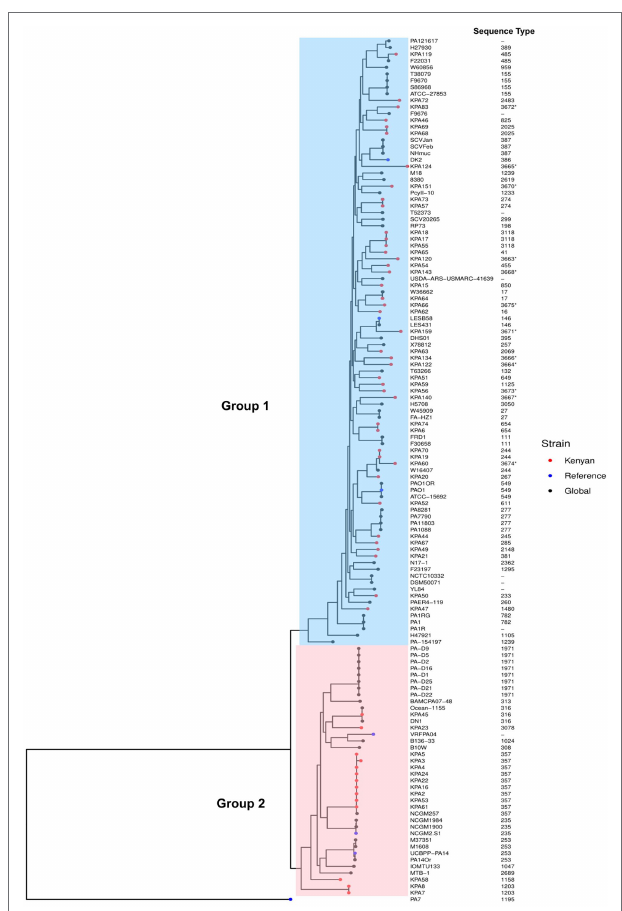
FIGURE 2 | Phylogenetic analysis of Kenyan and global strains of Pseudomonas aeruginosa . A maximum-likelihood phylogenetic tree of all study isolates and global strains of P. aeruginosa with their sequence types, demonstrating two distinct groups. Group 1 isolates are shaded blue, and Group 2 are shaded pink. Strains used in this study are indicated as red dots, global strains are black dots, and global reference strains are blue dots ( P. aeruginosa PAO1, P. aeruginosa VRFPA04, P. aeruginosa UCBPP-PA14, P. aeruginosa PA7, P. aeruginosa LESB58, P. aeruginosa NCGM2-S1, and P. aeruginosa DK2). The accession numbers of all genomes from GenBank used in this study are in Supplementary Table S2 . The sequence types are indicated adjacent to the strains on the phylogenetic tree. Asterisks (*) depict novel sequence